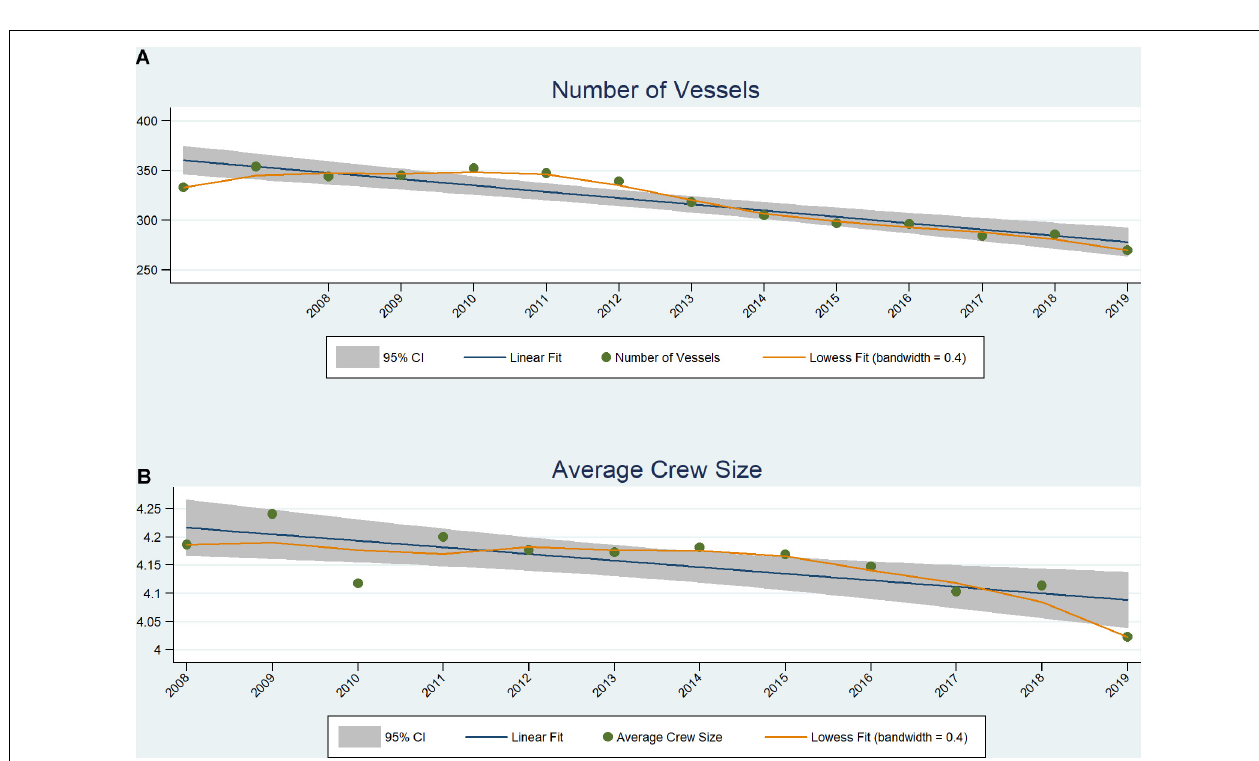
FIGURE 11 | Number of unique vessels (A) and average crew size per fishing trip (B) in the sablefish IFQ fleet. Figure includes the linear fit line and the 95% confidence interval around that line and the LOWESS fit curve calculated using a 0.4